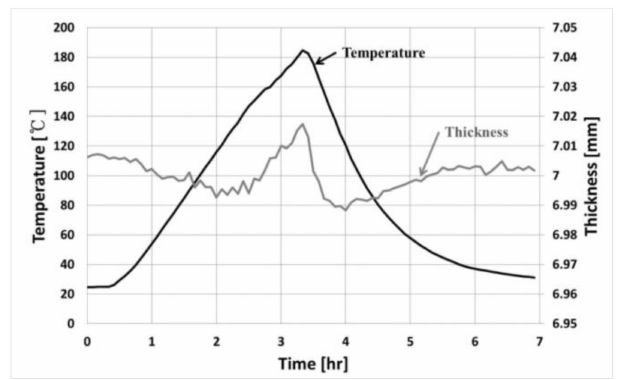
Figure 6. The measurement error by temperature variation in the developed